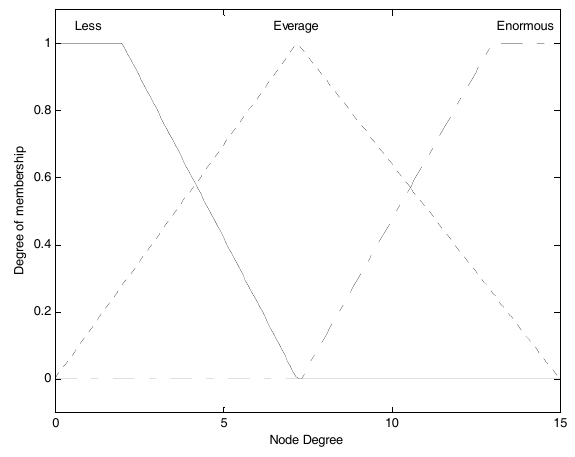
Figure 2. Nodes energy membership function.